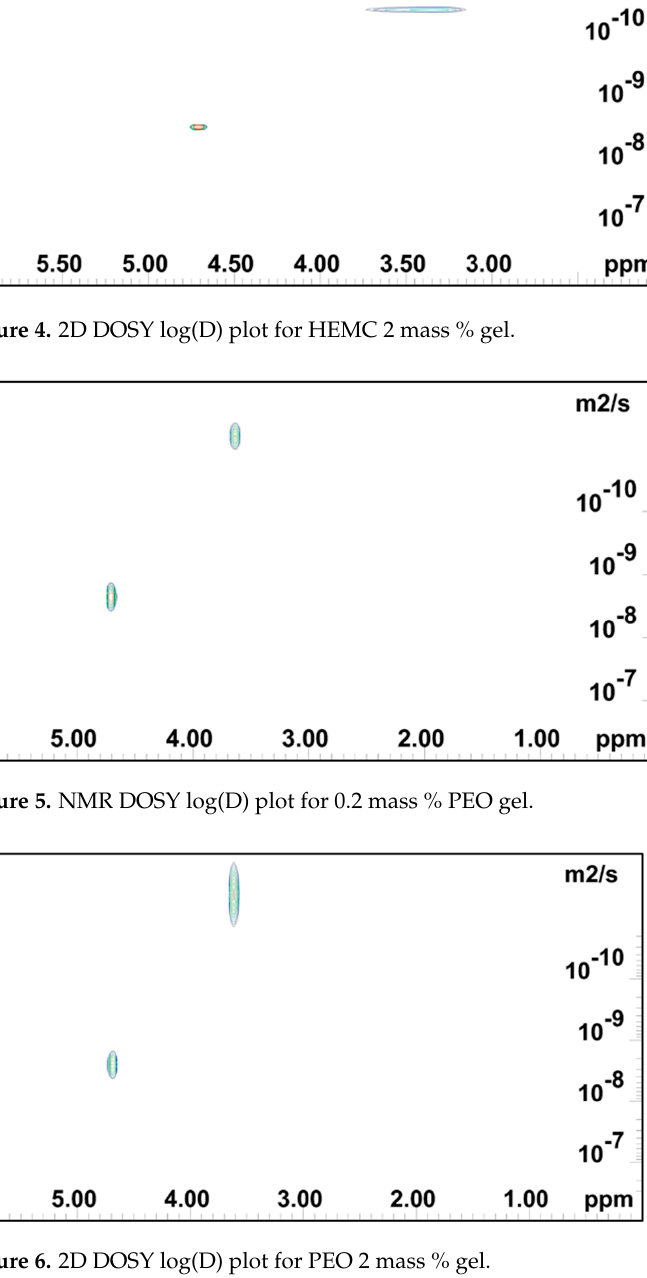
Figure 6. 2D DOSY log(D) plot for PEO 2 mass % gel.